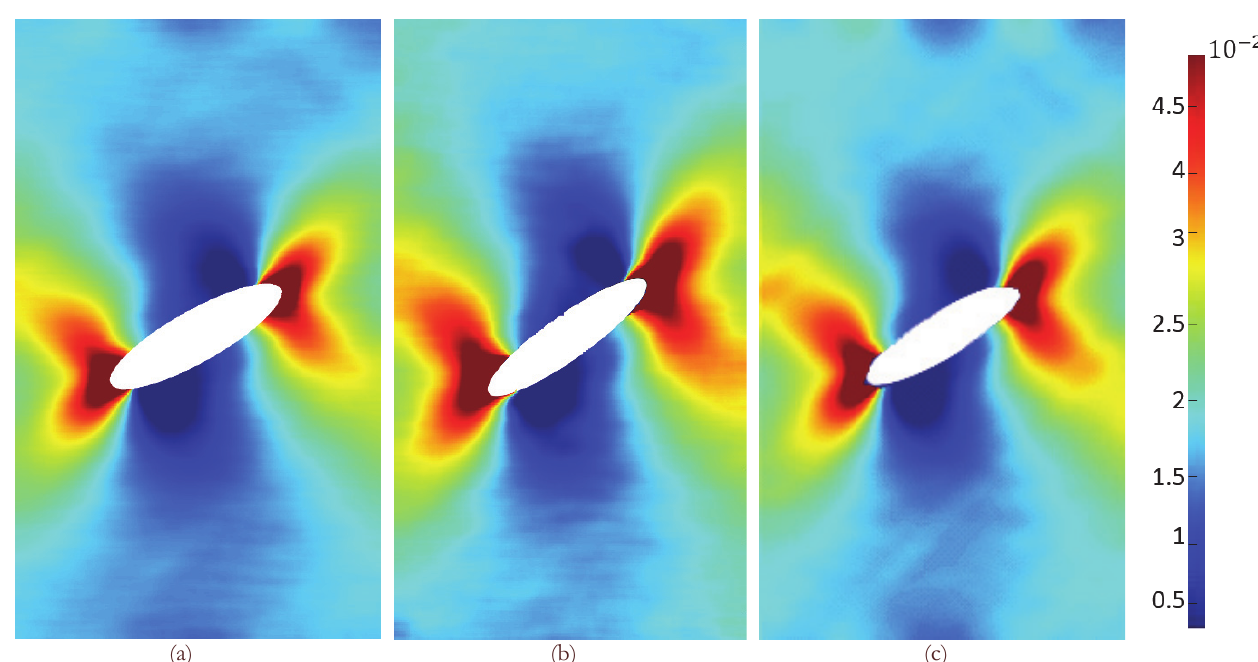
Figure 6: Map of the strain along X axis[-] of the elliptical hole with an aspect ratio 0.1, 60° inclined with respect to the load axis. Results computed, in order of appearance, with (a) LSM, (b) SGM, (c) NCORR.